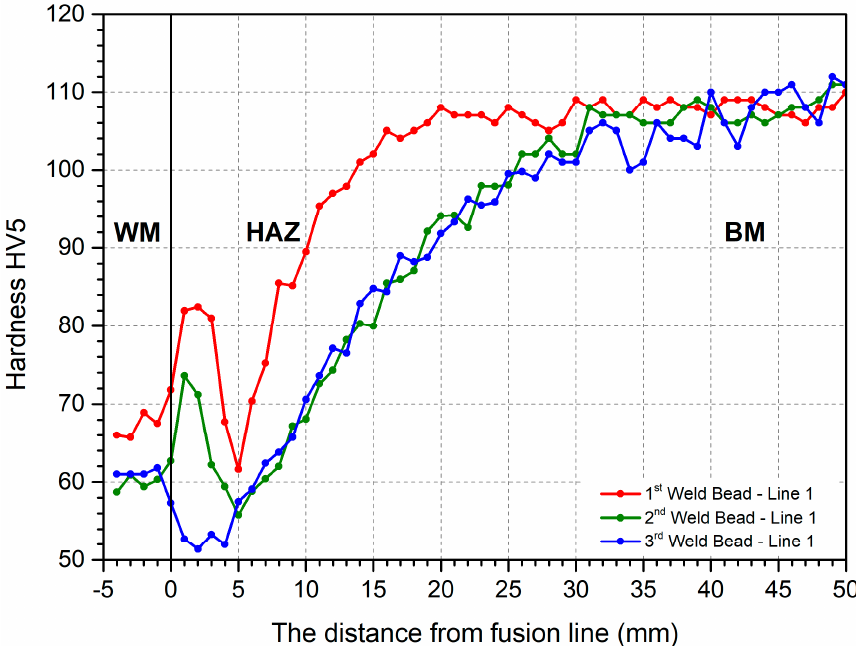
Figure 8. Measured hardness values in the weld metal, HAZ and base material for weld 1 (with preheating at 150 °C) in the zone of line 1 after application of one, two and three beads. To evaluate the structural changes in the HAZ, metallographic processing of the sample was performed, followed by microscopic evaluation on a MIRA 3 TESCAN electron microscope (Tescan Orsay holding a.s., Brno, Czech Republic). Figure 9a shows the microstructure of the HAZ after welding three weld beads with preheating at 75 °C. This area was located at a distance of 3 mm from the bottom edge of the sample (line 1) and at a distance of 4 mm from the fusion line. Therefore, this was the area most affected by multiple temperature cycles. Figure 9b shows the microstructure of the HAZ after welding three weld beads with preheating at 150 °C in the same location. Figure 9. Microstructure of HAZ after welding three weld beads at a distance of 4 mm from the fusion line ( a ), with preheating at 75 °C ( b ) and 150 °C.